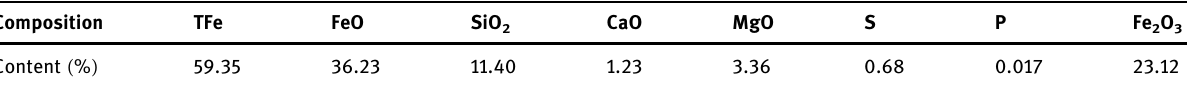
Table 2: Chemical composition of the converter precipitator dust Composition